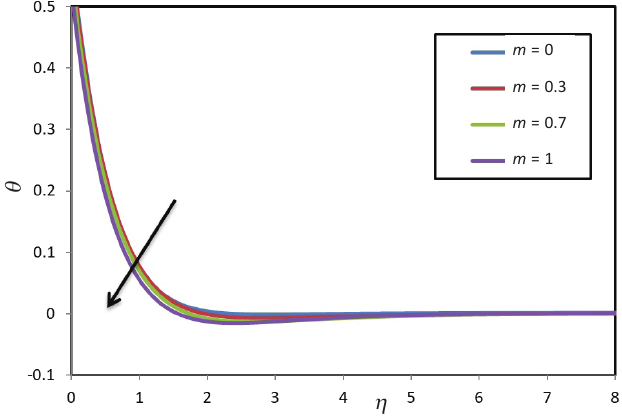
Fig. 9 – θ (temperature) versus h for K = 0.5, I = 0.5, F = –0.5 (heat sink), Pr = 100 (weak polymers), Ec = 0.2, with m = 0 (Blasius flow), 0.3 (wedge), 0.7 (wedge), 1.0 (stagnation